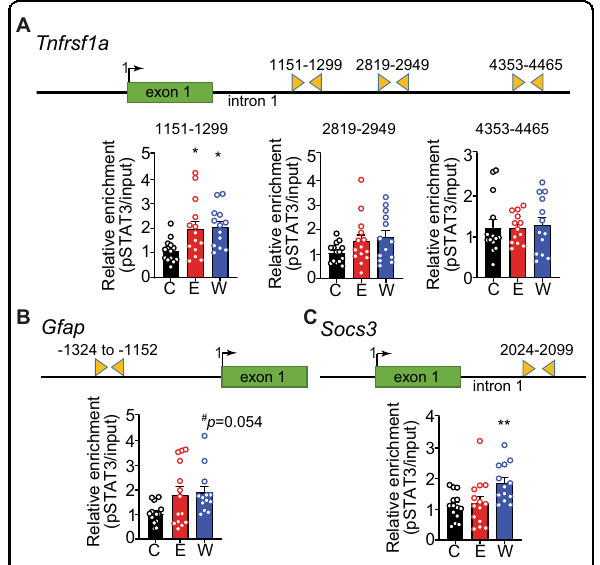
Fig. 3 Increased pSTAT3 enrichment at target genes in the hippocampus of ethanol withdrawn rats after chronic exposure. Rats were fed control liquid diet (C, n = 13), ethanol liquid diet (E, n = 14), or ethanol liquid diet ( n = 13) followed by 24 h of withdrawal from ethanol diet (W). The dorsal hippocampus was dissected and chromatin immunoprecipitation (ChIP) was performed using an antibody to phosphorylated STAT3 (pSTAT3), followed by qPCR with primers surrounding predicted STAT3 binding sites. Shown above each graph is a schematic of each gene with primer locations indicated by triangles. A Bar diagram shows relative pSTAT3 enrichment in the fi rst intron of Tnfrsf1a between 1151 and 1299 bp downstream of the transcription start site but not at sites further downstream (2819 – 2949 and 4353 – 4465). Bar diagrams show relative pSTAT3 enrichment at the B Gfap promoter and C fi rst intron of Socs3 .